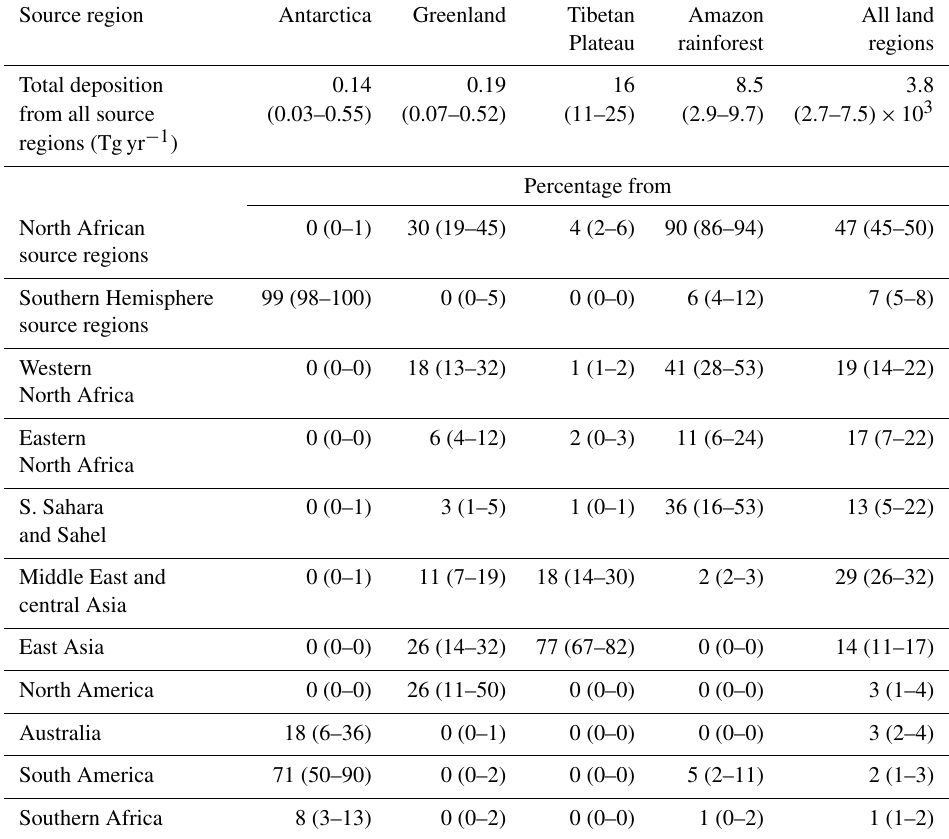
Table 2. Constraints on the contribution of dust deposition from each source region to land areas where dust deposition produces important impacts, namely the high-albedo regions of Antarctica, Greenland, and the Tibetan Plateau, as well as the Amazon rainforest. Listed are median values, with 1 standard error intervals listed in parentheses. The coordinates of the Amazon rainforest follow the definition given in Yu et al. (2015), and the Tibetan Plateau was taken as the region with elevation over 4000m between 26–40 ◦ N and 75–105 ◦ E based on Easter et al. (2004). These regions are plotted in Fig.